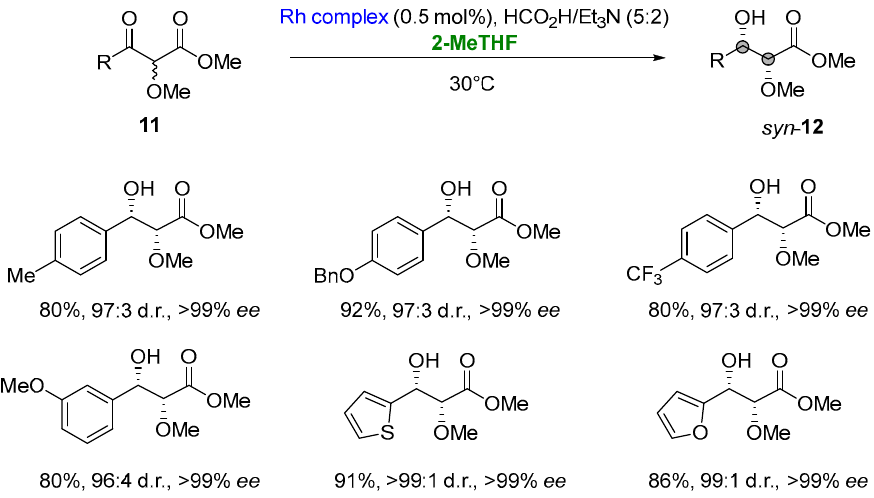
Figure 9. Synthesis of bortezomib through asymmetric Rh-catalyzed borylation of aa leucine analogue.